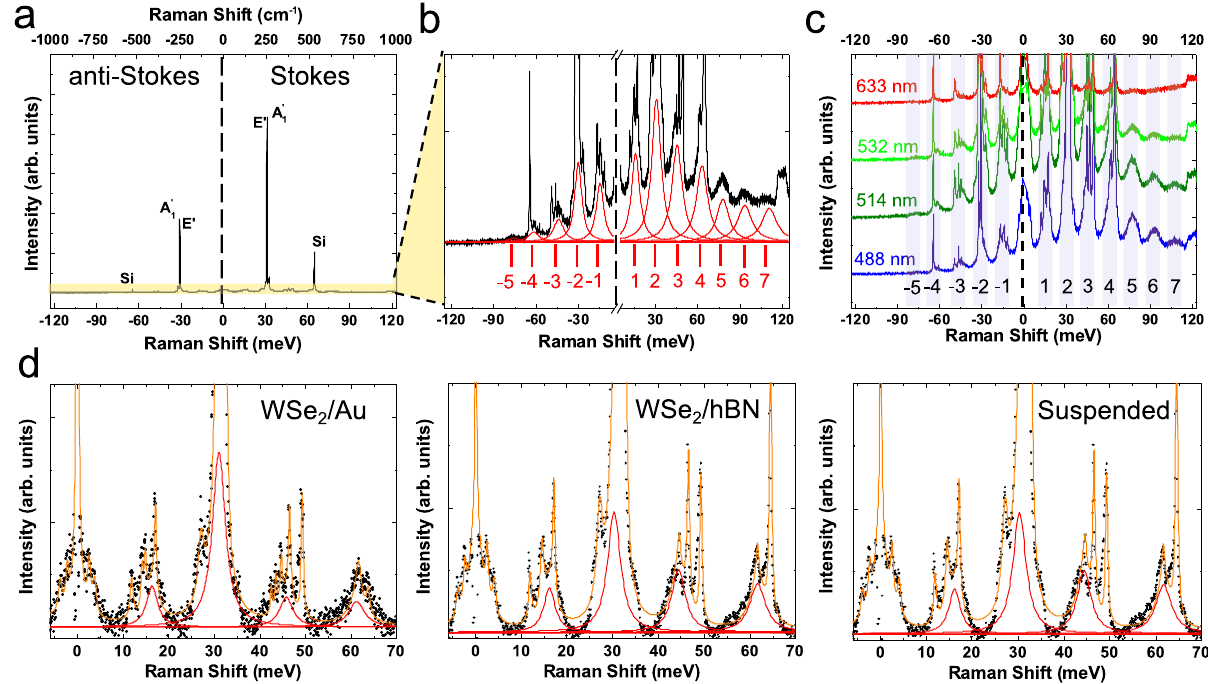
Fig. 1 Raman and hot PL spectra of 1L-WSe 2 . a Emission and scattering spectrum of 1L-WSe 2 at 295K as a function of energy shift with respect to the excitation laser (532nm~2.33eV). The degenerate in-plane ( E 0 ) and out-of-plane ( A 0 ) Raman mode ~250cm − 1 43 , as well as the Si Raman peak ~521cm − 1 47 , 1 are prominent in both S and AS. b Magni fi ed portion of the spectrum in yellow in a . This reveals 7 periodic S peaks and 5 AS. Their intensity decreases as a function of the energy shift for both S and AS. c Raman spectra of 1L-WSe 2 on SiO 2 /Si at 488, 514, 532, 633nm and 295K, shifted vertically for clarity. d Raman spectra of 1L-WSe 2 on different substrates (Au, hBN and suspended) at 295K and 514nm excitation. Black points: experimental data. Red lines: fi tted cascades. Orange line: sum of fi tted